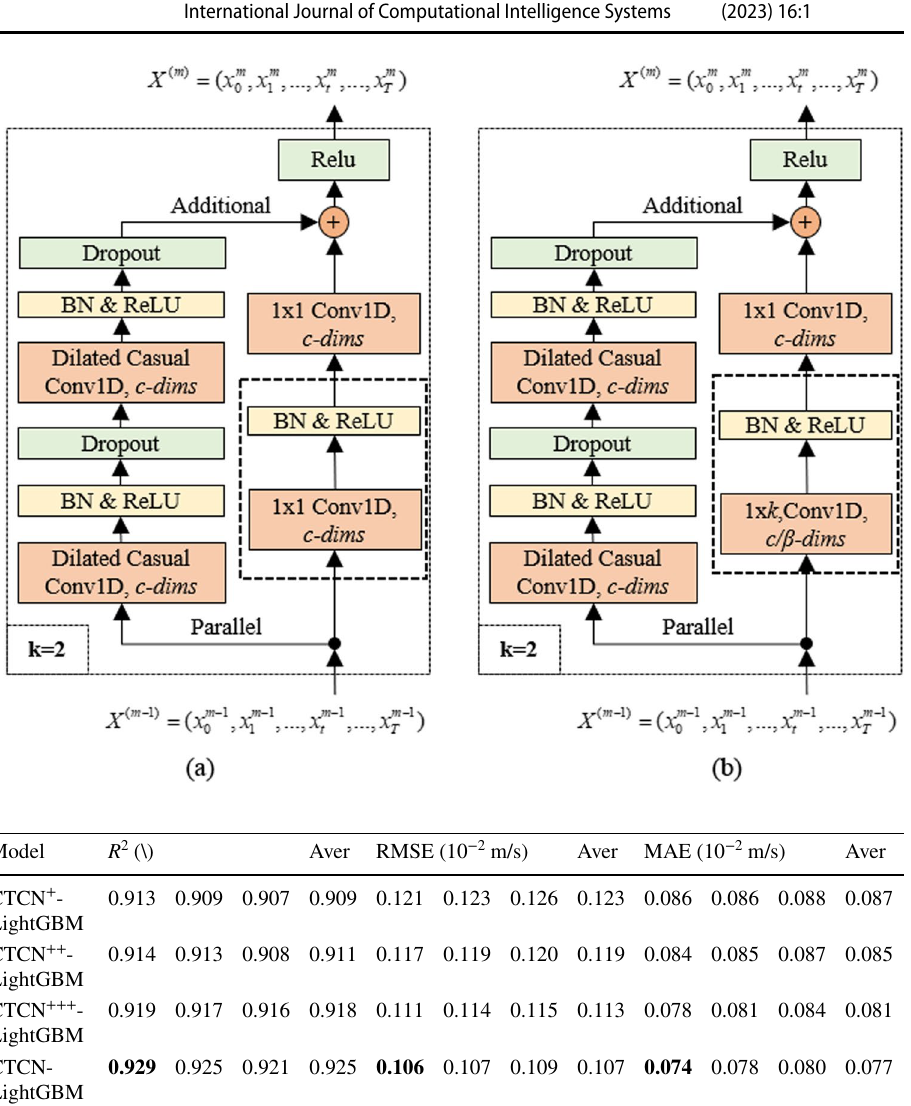
The bold values indicate superior metric values of the proposed CTCN-LightGBM Table 5 Ablation classification results of each model for the truck speed adjustment